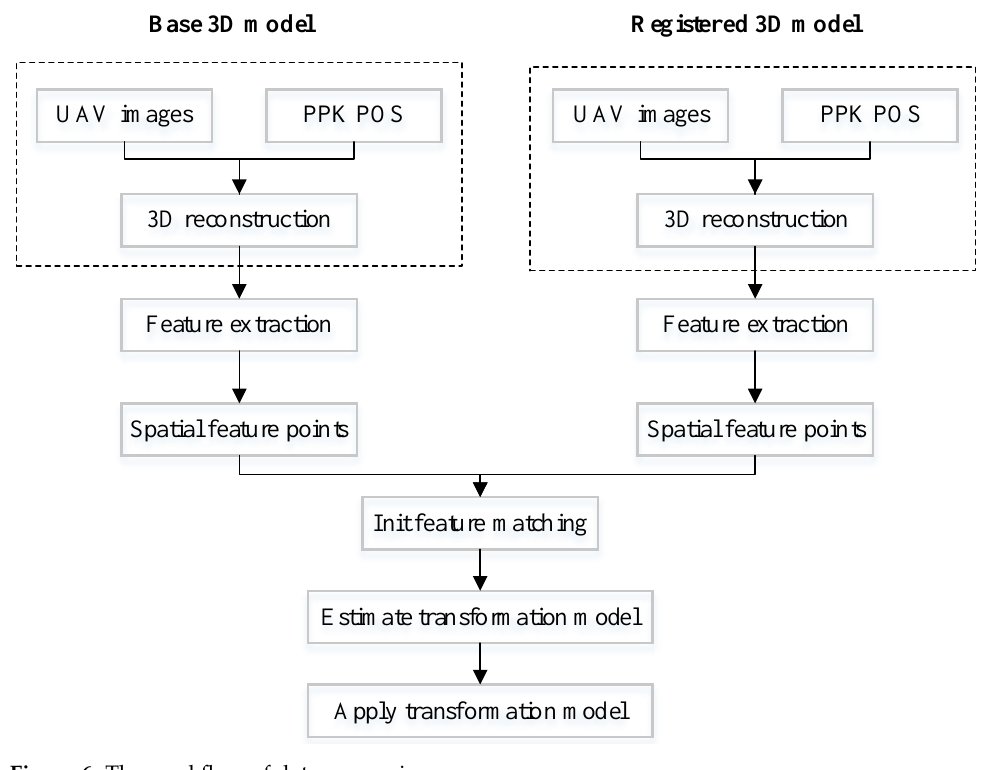
Figure 6. The workflow of data processing.